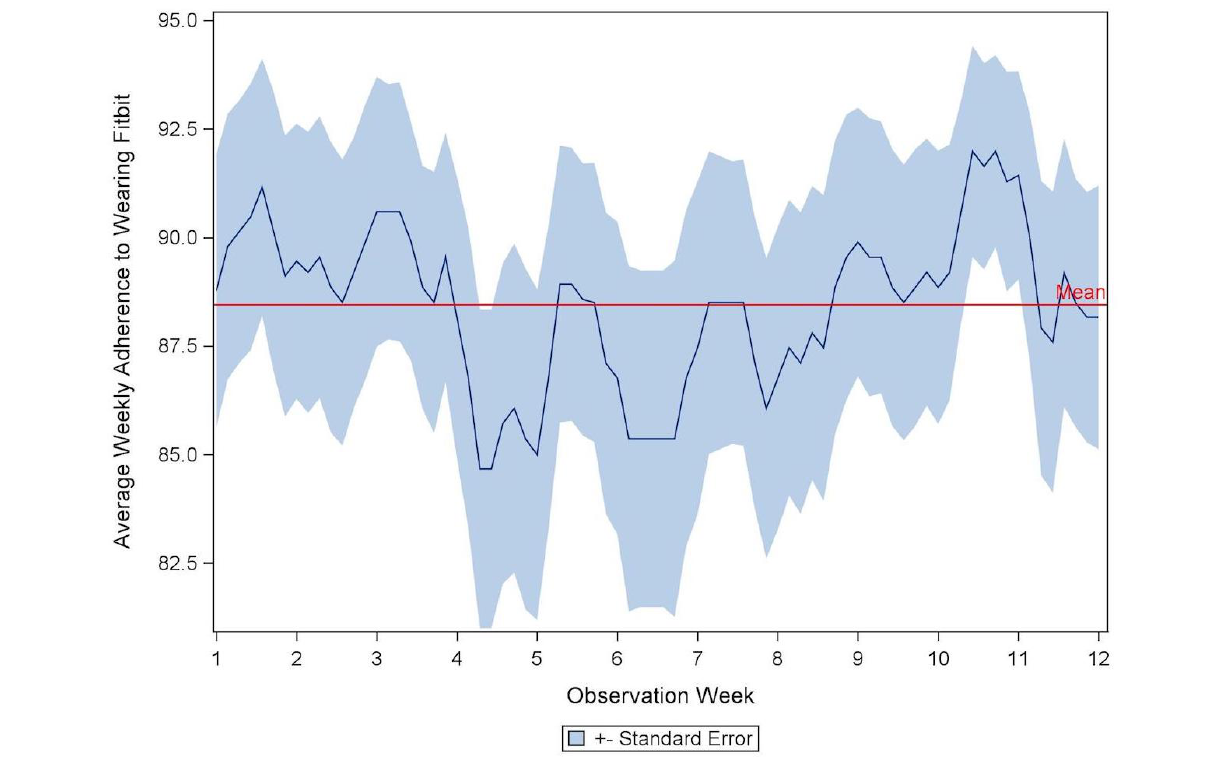
Figure 1. Rolling weekly percent adherence to wearing the Fitbit, averaged across study participants (standard error), reference line at overall 12 week average,